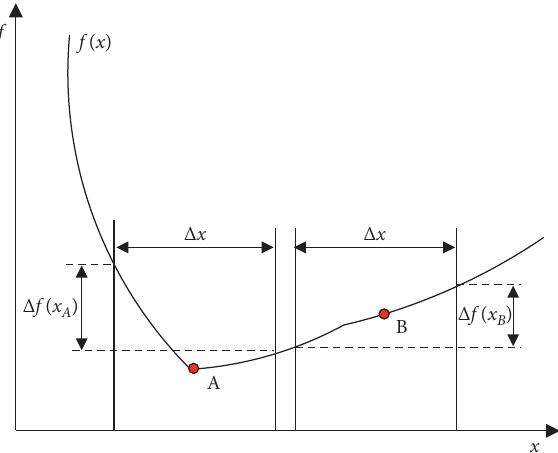
Figure 3: Schematic diagram of objective